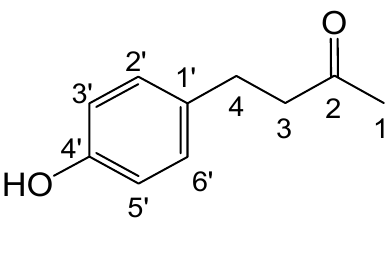
Figure 1. Chemical Structure of Raspberry Ketone